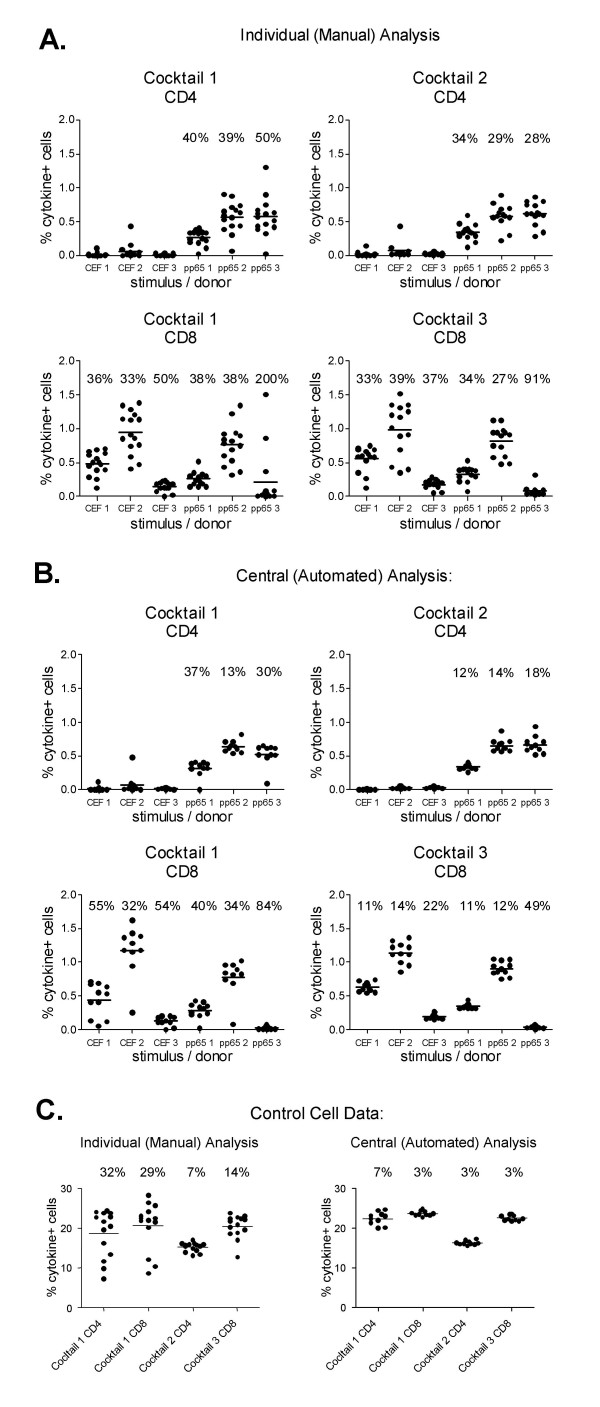
Results of Experiment 4 (cryopreserved PBMC with lyophilized reagents). Cytokine-positive cells in response to CEF peptides or CMV pp65 peptide mix are expressed as a percentage of CD4+ or CD8+ T cells. Results from each site are indicated as a circle, with median responses for each sample indicated as a horizontal bar. Sample names are listed along the X axis. The C.V. for each positive sample is listed across the top of each panel, along with the mean C.V. for that set of samples. (A) Data reported by individual sites. (B) Data after centralized analysis using a dynamic gating template. Cocktail 1 consisted of CD4 FITC/IFNγ +IL-2 PE/CD8 PerCP-Cy5.5/CD3 APC. Cocktail 2 consisted of IFNγ FITC/CD69 PE/CD4 PerCP-Cy5.5/CD3 APC, and cocktail 3 consisted of IFNγ FITC/CD69 PE/CD8 PerCP-Cy5.5/CD3 APC. (C) Control cell data from Experiment 4. Activated, processed, and stained PBMC were lyophilised and run as controls by each site in Experiment 4. These cells had been stained with cocktail 1, 2, or 3. The left panel shows data reported by individual sites; the right panel, data after centralized analysis using a dynamic gating template. Most of the inter-lab variability was removed by this method of analysis.